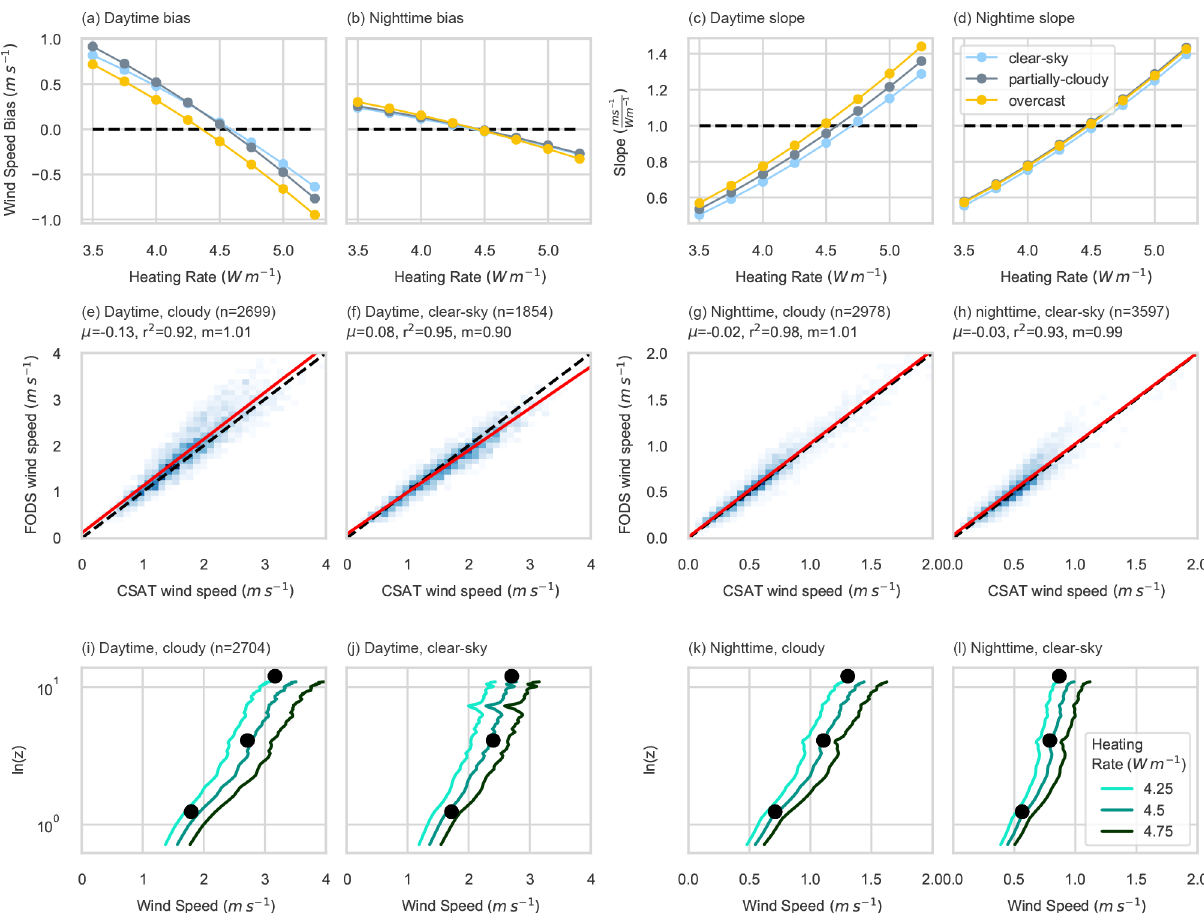
Figure 8. The heating rate of the fiber-optic cable was varied when deriving the FODS wind speed following van Ramshorst et al. (2020). The (a, b) bias and (c, d) slopes in FODS wind speed evaluated against the horizontal wind speed observed by the 1.25m sonic anemometer. Data were stratified according to solar light and the cloud regime. For the heating rate of 4Wm − 1 , two-dimensional histograms of the evaluation are shown for daytime (e–f) and nighttime (g–h) . The caption indicates the bias ( µ ), correlation coefficient ( r 2 ), linear slope ( m ), and number of minutes evaluated for each regime classification. For these same regime classifications, (i–l) vertical profiles of wind speed are shown for a varying heating rate. The dots indicate the mean horizontal wind speed observed by the sonic anemometers at 1.25, 4, and